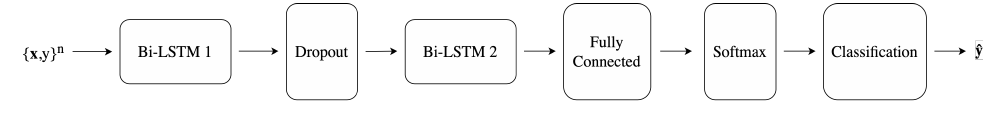
Figure 8. Network configuration of the proposed